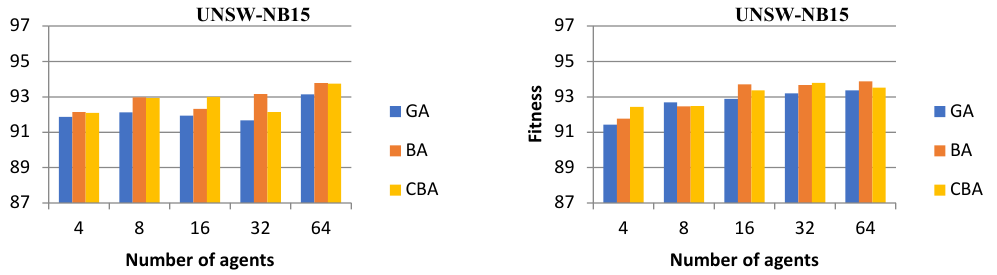
Figure 5. The fitness of the heuristic algorithms on the NSL-KDD when the iterations are 10 and 20.